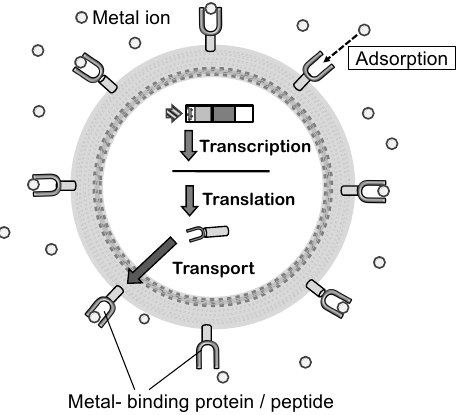
Figure 3. Mechanism of molecular display and constructional model bioadsorbent. Displayed metal-binding protein or peptide on the cell surface can bind a metal ion. The figure was adapted from [46].